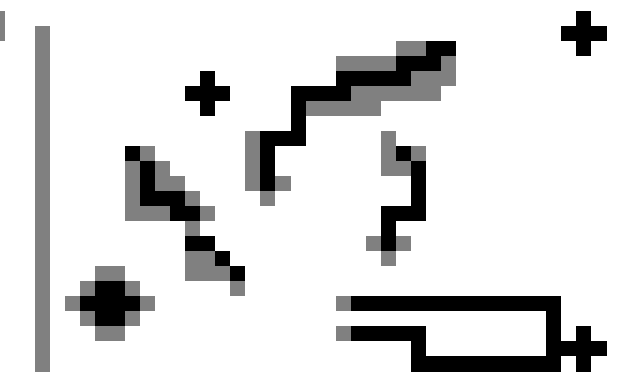
Fig. 13. Random map input as image file